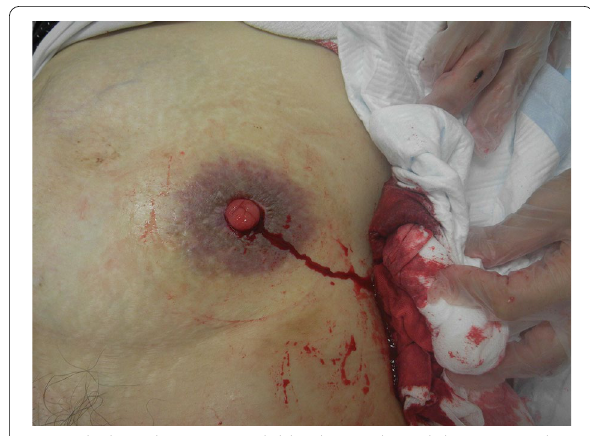
Fig. 1 Ileal conduit stoma with bleeding and purplish peri-stomal